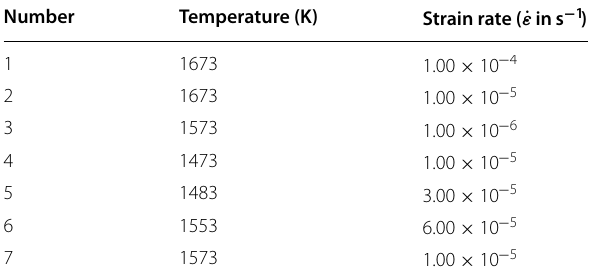
Table 3 Temperatures and strain rates used to generate the synthetic data for the MCMC benchmark. The initial condition for all the variable in the state vector are zero